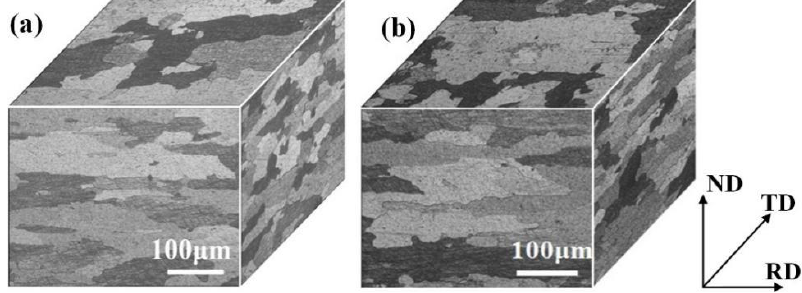
Figure 14. OM images of two T3-tempered samples: ( a ) Sample 1; ( b ) Sample 2.